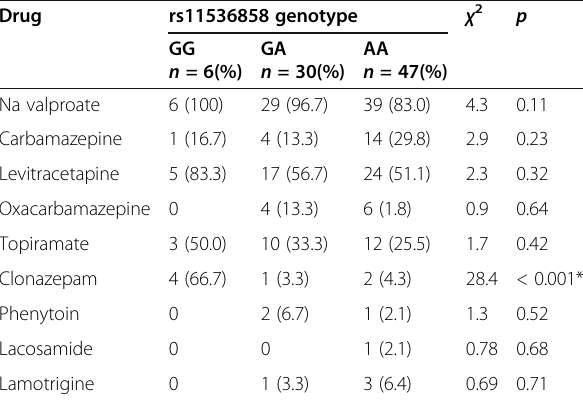
Table 8 Association between rs11536858 genotype